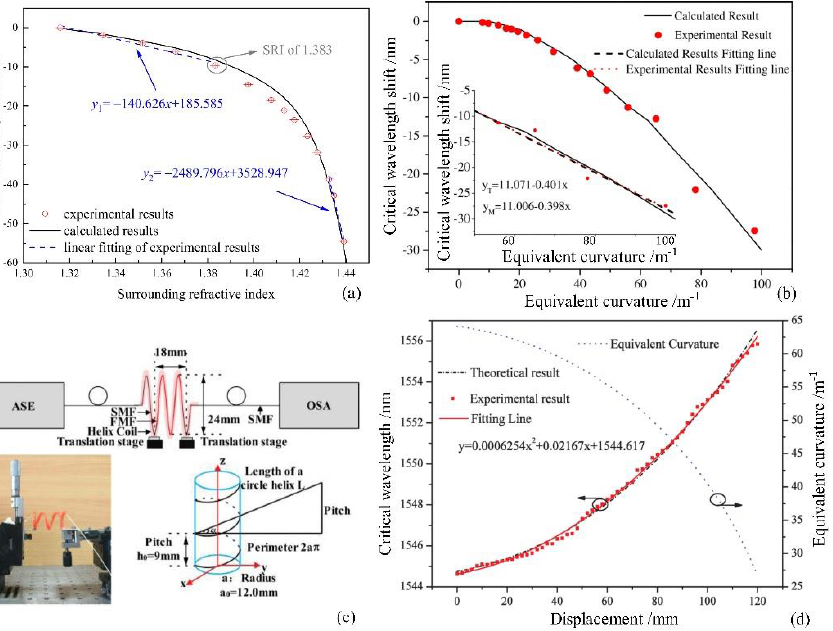
Figure 12. The wavelength shifts in CWL and sensor structures employing the few-mode fiber in the SFS structure; ( a ) experimental (marks with error bars) and calculated results of CWL shift with SRI variations. @ (2017) IEEE. Reprinted, with permission, from [8] ; ( b ) calculated and experimental results of CWL shift with equivalent curvature. @ (2016) IEEE. Reprinted, with permission, from [6] ; ( c ) schematic diagram of the experiment setup of the displacement sensor employing SFS structure; ( d ) the experimental and the theoretical results of the CWL changes in the sensor and the theoretical equivalent curvature of FMF in the helix coil (dashed line) versus displacement. @ (2016) IEEE. Re- printed, with permission, from [7] .